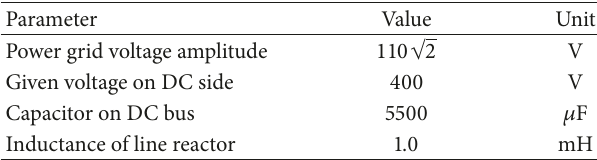
Table 1: Simulation parameters and